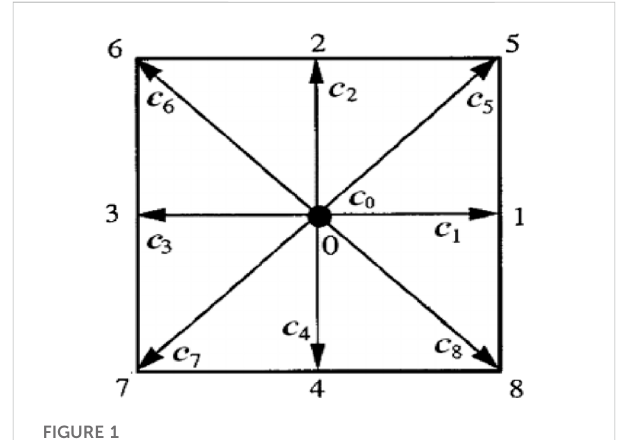
FIGURE 1 Two-dimensional nine-velocity particle